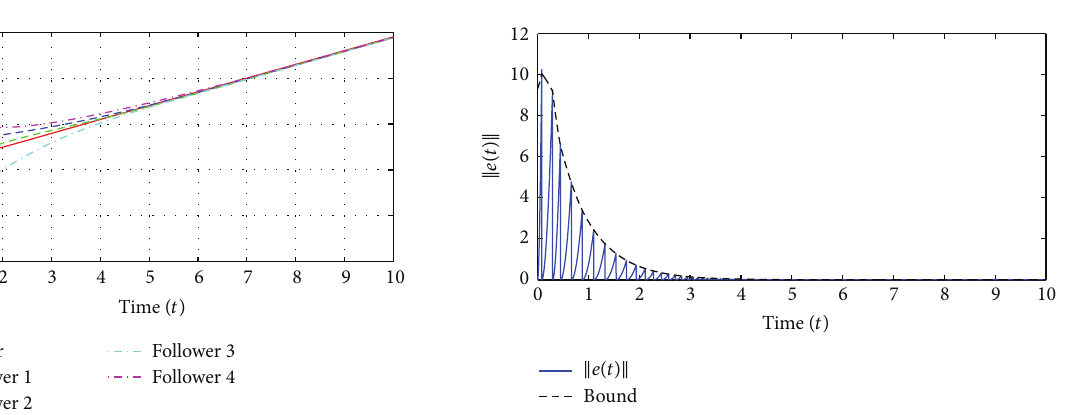
Figure 9: Evolution of the measurement error norm ‖𝑒(𝑡)‖